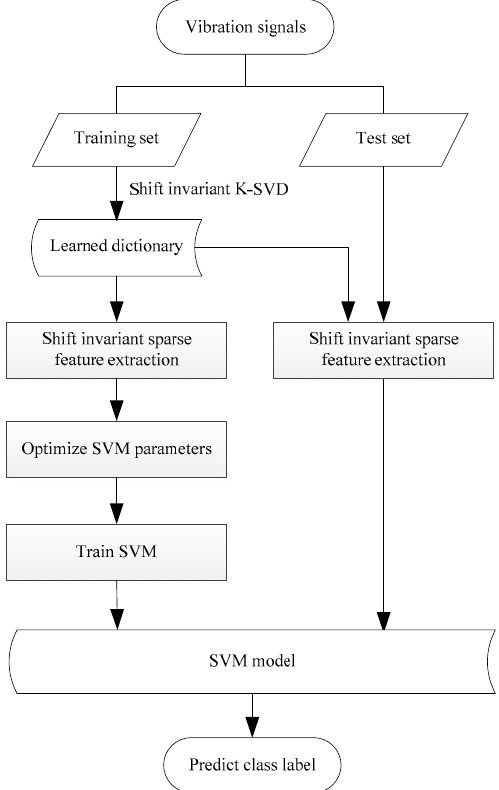
Figure 1. Diagram of the proposed method.